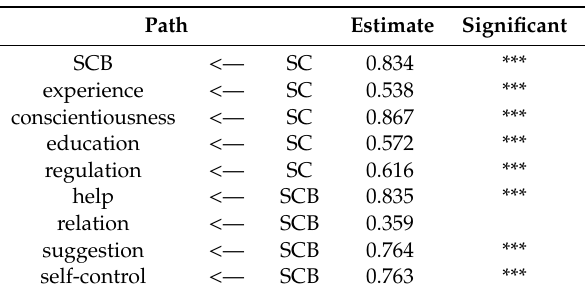
Table 13. Path coefficients of SEM. Table 13. Path coe ffi cients of